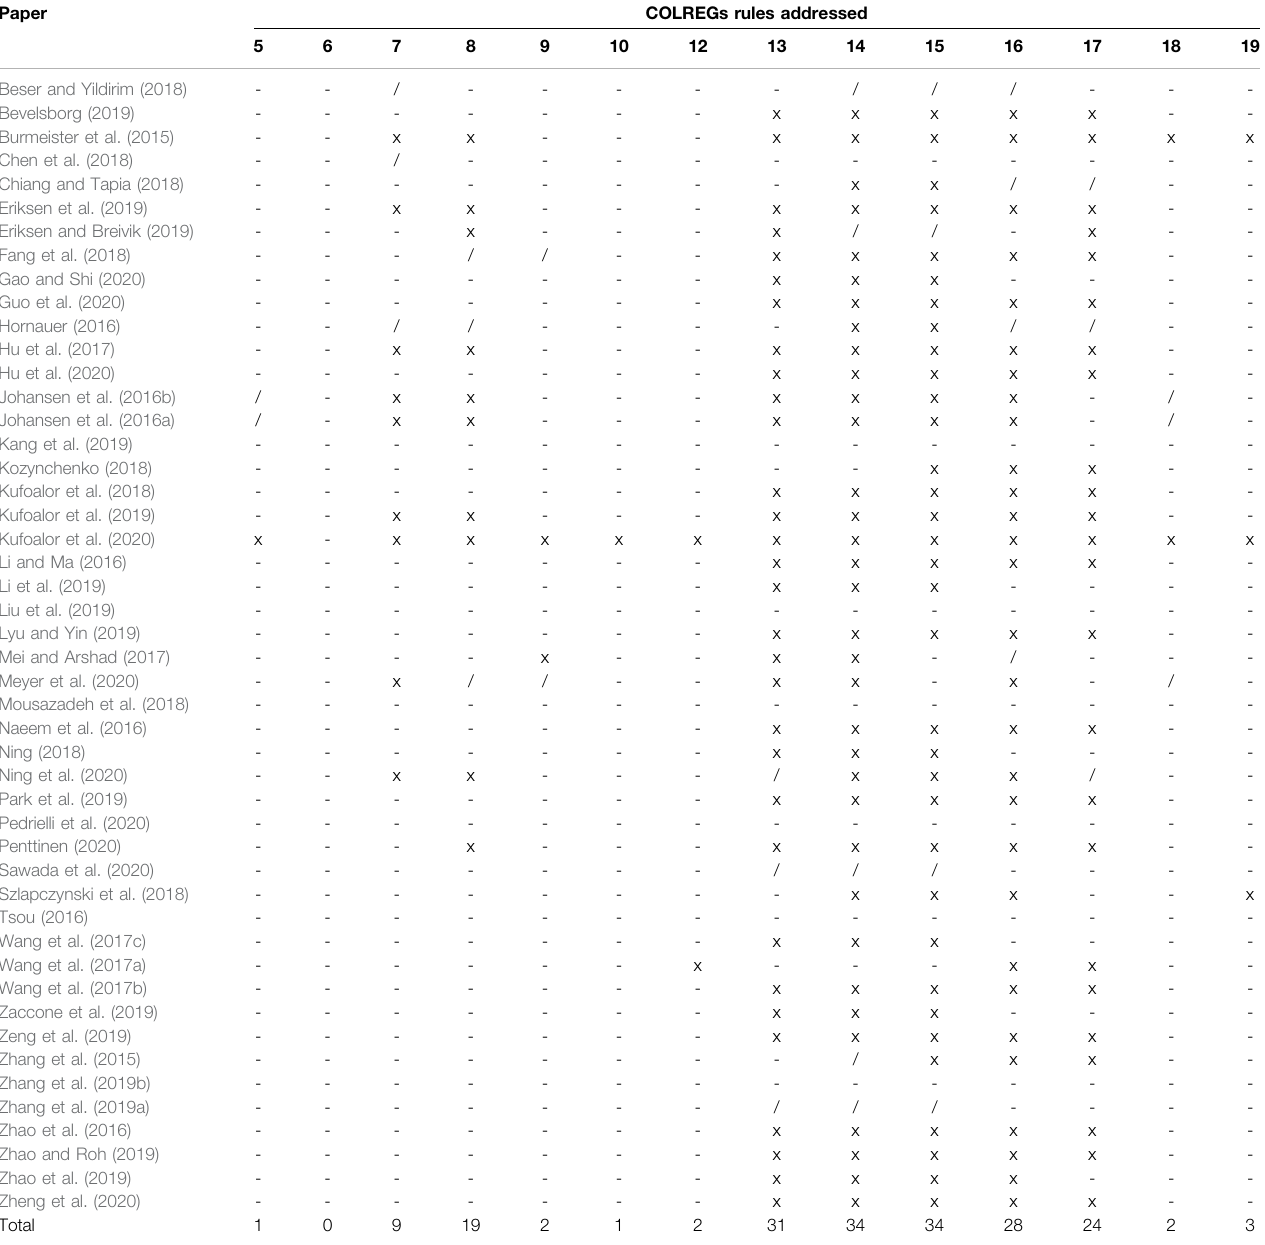
TABLE 1 | Papers 1 to 10: COLREGs rules addressed by investigated approaches.